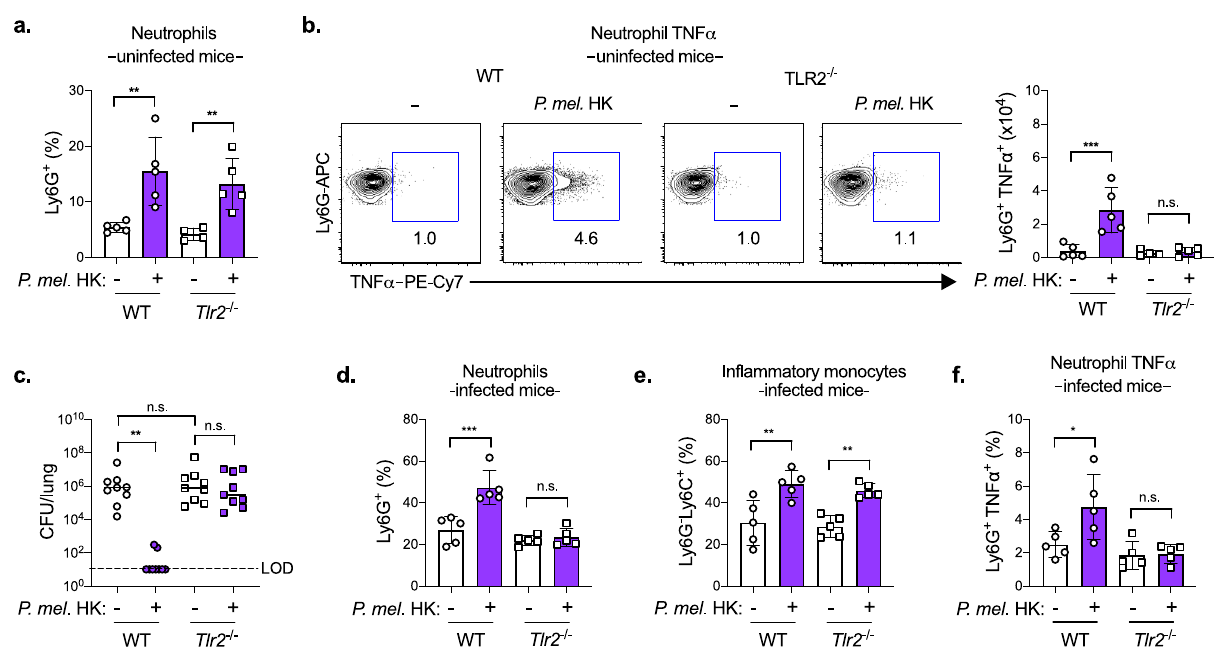
Fig. 6 TLR2 is required for P. melaninogenica ( P. mel .)-induced neutrophil TNF α and protection against S. pneumoniae. a , b Percentage of neutrophils ( a ), representative fl ow cytometry plots and total cell numbers of neutrophil TNF α ( b ) detected by intracellular fl ow cytometry in WT or Tlr2 -/- mice treated with either PBS (-) or P. mel . strain 25845 heat-killed (HK) i.t. for 24 h ( n = 5 mice/group). c – f Lung type 2 S. pneumoniae burdens ( n = 9